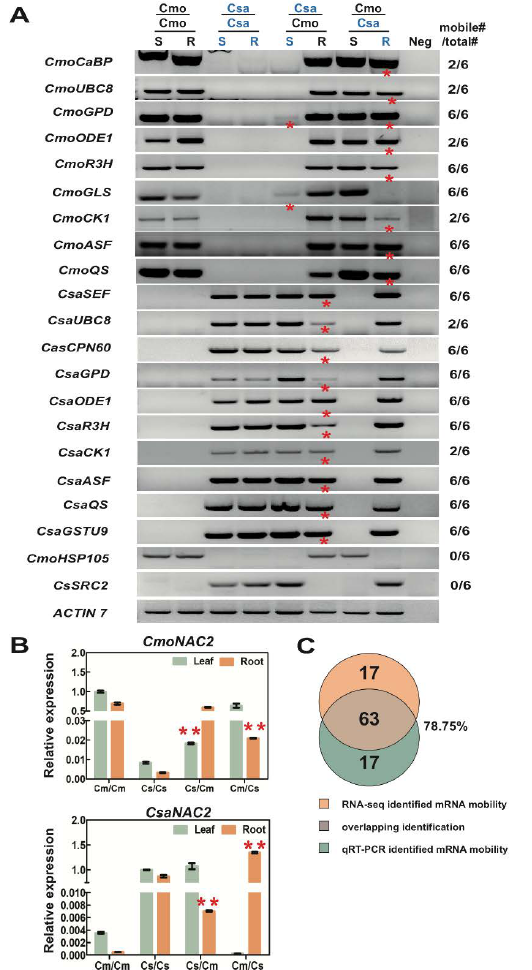
Figure 7. Identification of Csa and Cmo mobile transcripts using RT-PCR and RT-qPCR in heterograft systems. ( A ) RT-PCR assays with specific primers confirm CmoCaBP , CmoUBC8 , CmoGPD , CmoODE1 , CmoR3H , CmoGLS , CmoCK1 , CmoASF , CmoQS , CsaSEF , CsaUBC8 , CsaCPN60 , CsaGPD , CsaODE1 , CsaR3H , CsaCK1 , CsaASF , CsaQS, and CsaGSTU9 underwent either unique or double directional movement in heterografts. CmoHSP105 and CsaSRC2 were not detected in the mobile mRNA list. Each graft combination was divided into six heterograft pool replicates, and each pool included 6–9 individual grafted plants. Red asterisks indicate the direction of mRNA transport, and the ratio numbers indicate mRNA mobility detected in sample repetitions by RT-PCR. Csa, Cucumis sativus ; Cmo, Cucurbita moschata ; S, shoot; R, root; Neg, negative. ( B ) RT-qPCR analysis of Csa / CmoACTIN7 as an internal reference was conducted on heterograft Cmo and Csa samples. Specific primers for RT-qPCR were verified to only recognize CmoNAC2 transcripts, and did not amplify CsaNAC2 transcripts to any significant extent. A significant increase in the Csa root of Cmo / Csa heterografts allowed us to determine potential Cmo mRNAs’ downward movement. Likewise, CsaNAC2 transcript downward mobility was identified in the same way. Cs, Cucumis sativus ; Cm, Cucurbita moschata . Red asterisks indicate significant di ff erences ( < 0.001) amongst the same tissue of homograft controls using t -test for independence of variables in a contingency table. Biological replicates: n > 9. Graphs were generated by GraphPad Prism5.0. Error bars indicate standard deviation. ( C ). Venn map indicates a correlation (78.75%) between RNAseq and RT-qPCR identification assays. Eighty mobile mRNAs were selected for testing, and 63 of them matched mobility identified by